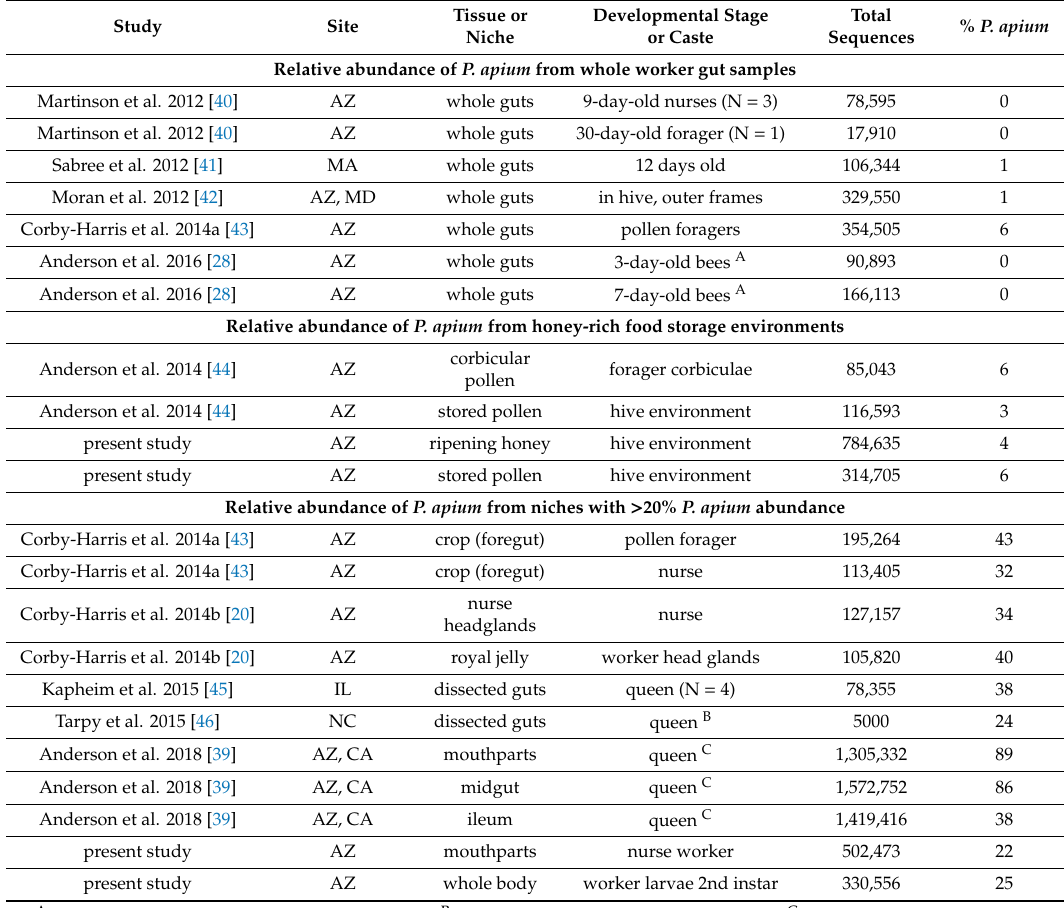
Table 1. Relative abundance of Parasaccharibacter apium by niche and study. Study Site